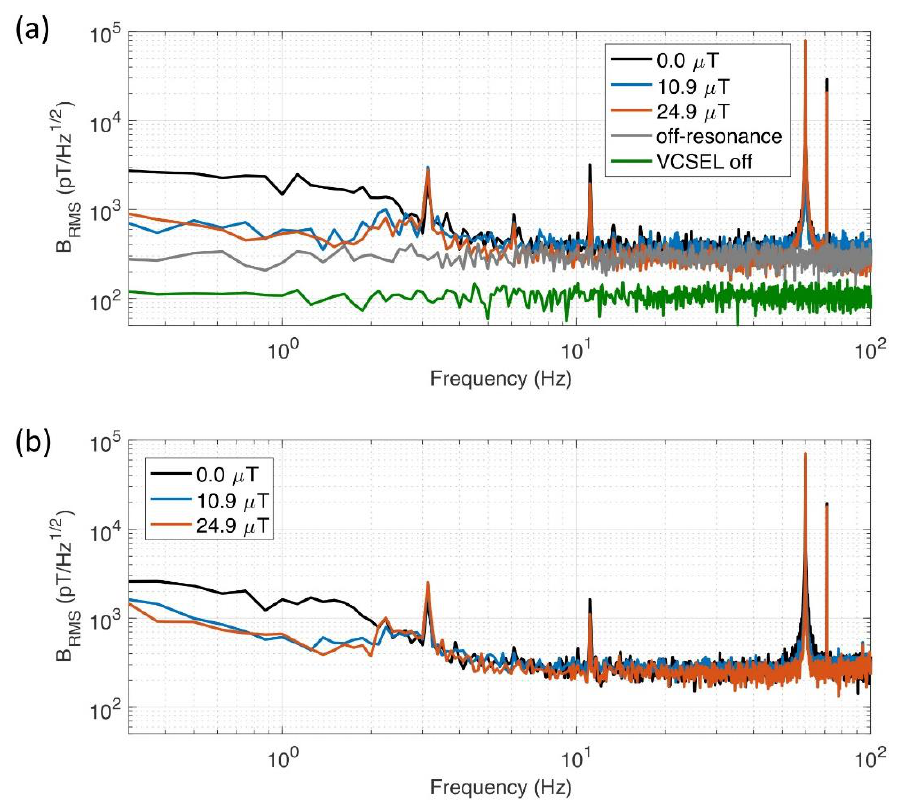
Figure 6. ( a ) Field noise spectral density obtained by Fourier analysis of the LIA output in the open loop mode. Black: 0.0 μT, blue: 10.9 μT, and red: 24.9 μT. For reference purpose, the results for completely off-resonant microwave frequency (gray) and in the absence of laser light (green) are overlaid. ( b ) Field noise spectral density obtained from the feedback signal of PID servo controller in the closed loop-mode. Same color code as ( a ) for target magnetic fields.